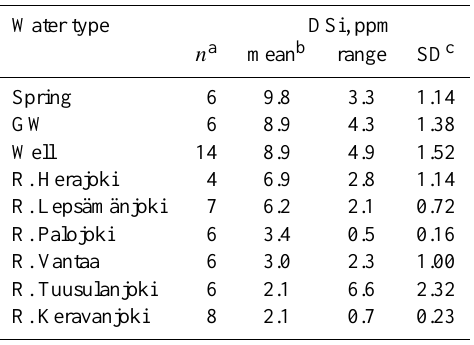
Table 4. The mean, range and standard deviation of DSi values of water samples in summer